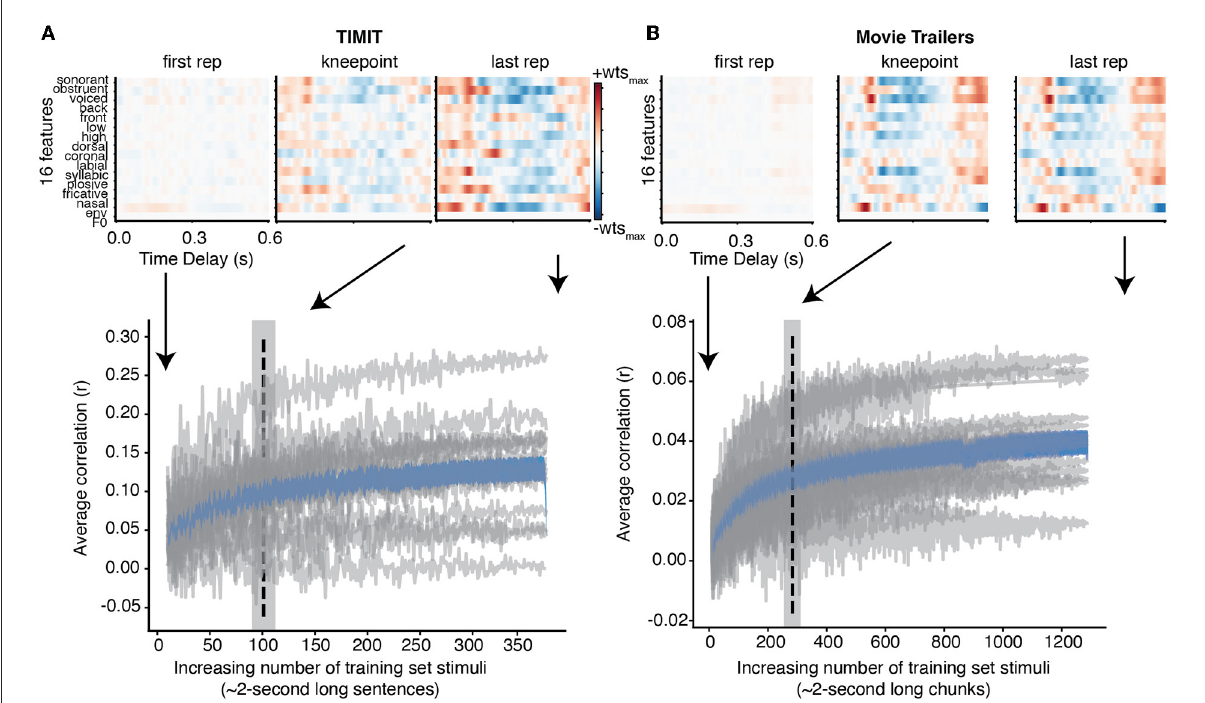
FIGURE1 Individual and average correlation values with increasing training data. (A) For TIMIT, each gray line shows how the correlation values change for an individual subject when adding each additional TIMIT sentence to the training data. The average increasing correlation value of all subjects is shown in blue with standard error. The dashed vertical line at 96 sentences indicates the average knee point across all subjects (gray shading shows standard error of the mean). Finally, the weights for the full model for a single subject with the highest correlation values (MT0008) is shown at the first repetition (e.g., when there is only one TIMIT sentence to train on), the knee point, and the final repetition (e.g., after adding all TIMIT sentences specified in the training set). The structure of the receptive field at the knee point and at the last repetition is qualitatively similar. (B) Same as TIMIT but for movie trailers. Again, the receptive field at the knee point (with only 565.75s of training data) is qualitatively similar to the receptive field at the last repetition